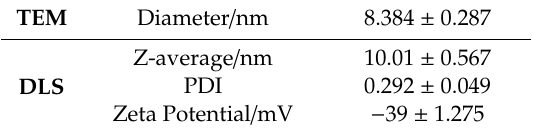
Table 1. General features of the “green” AgNPs obtained with 350 µ moL metal precursor.